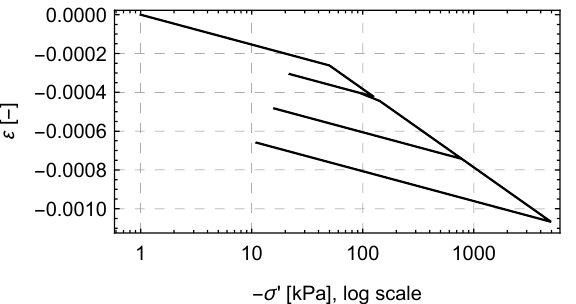
Figure 12. Relationship between log σ (cid:48) and strain produced by the preconsolidation model for η = 0 and σ (cid:48) p = 50